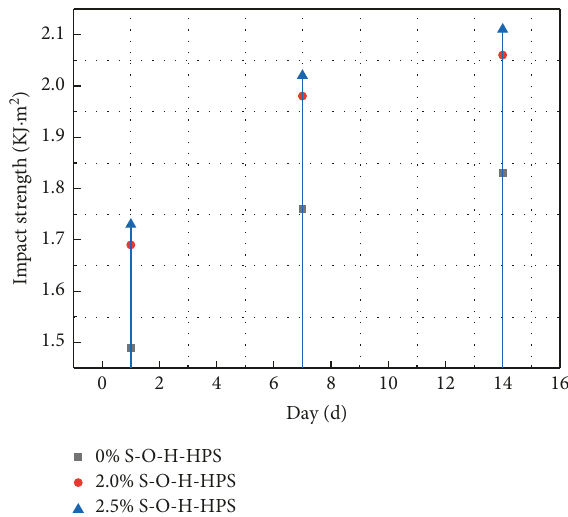
Figure 12: Effect of curing age on impact strength of cement